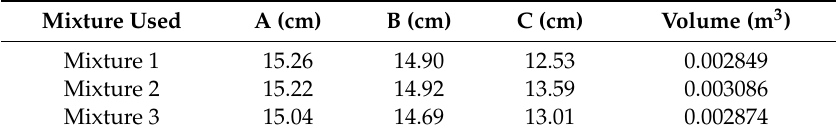
Table 2. Volume of the samples tested for three composite materials